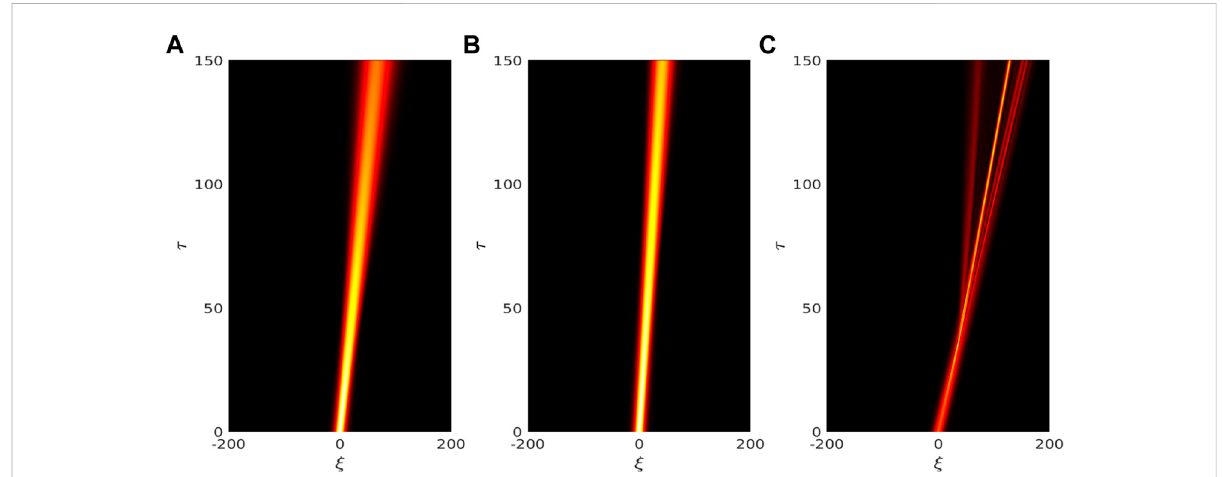
FIGURE 5 Dynamical evolution of EM solitons [Numerical solution of Eq. 14] for different parameter values that correspond to stable [subplot (B) ] and unstable [subplots (A) and (C) ] regions [ cf . Figure 4]. The parameter values for the subplots (A) to (C) , respectively, are R 0 = 20, λ = 1.5, v 0 = 0.6, α = 0.01, k 0 = 0.5; R 0 = 30, λ = 0.2, v 0 = 0.6, α = 0.01, k 0 = 0.5; and R 0 = 30, λ = 0.2, v 0 = 2, α = 0.01, k 0 =